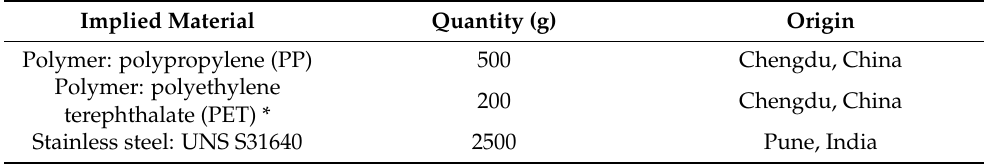
Table 4. Material composing the final product. These are common materials used in the automotive industry [43,44].